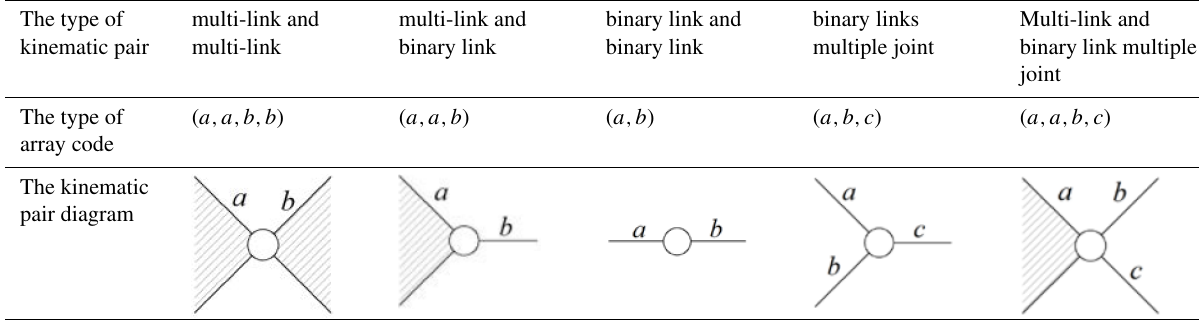
multi-link and multi-link